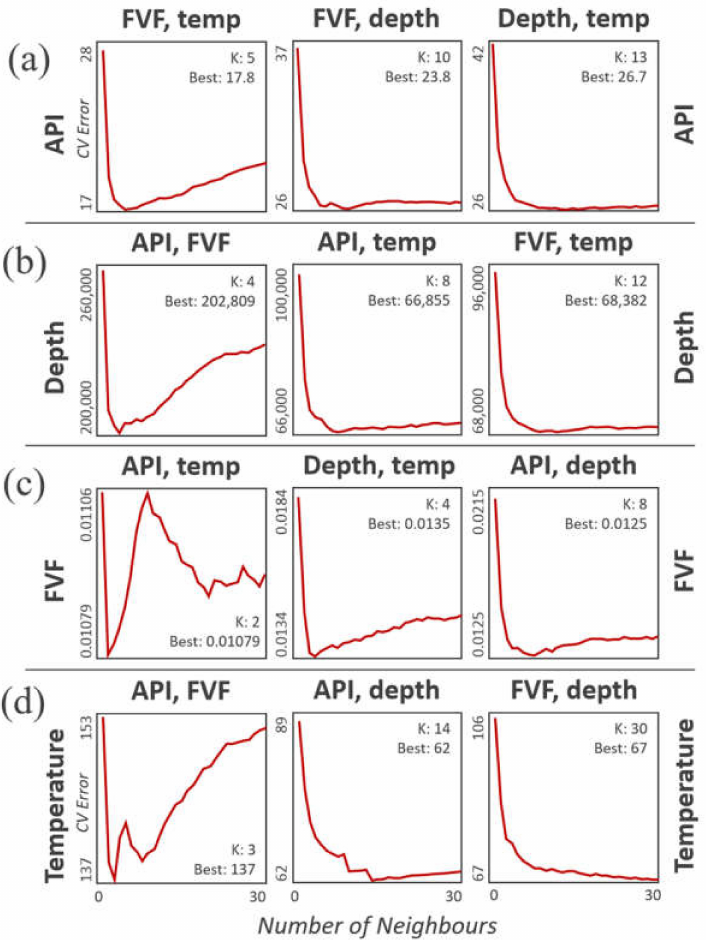
Figure 15. KNN cross-validation (CV) error curves for each variable in three-dimensional space. The input features are listed on the horizontal axis, and the target variable listed on the vertical where: ( a ) API; ( b ) depth; ( c ) FVF; ( d ) temperature. Where the error curve (red) has a declining shape with increasing number of neighbours ( x -axis), the target variable does not depend on the distance between the input data and is therefore not relevant to input features. An error curve that features a distinct minimum corresponds to a KNN estimate for data that can be spatially